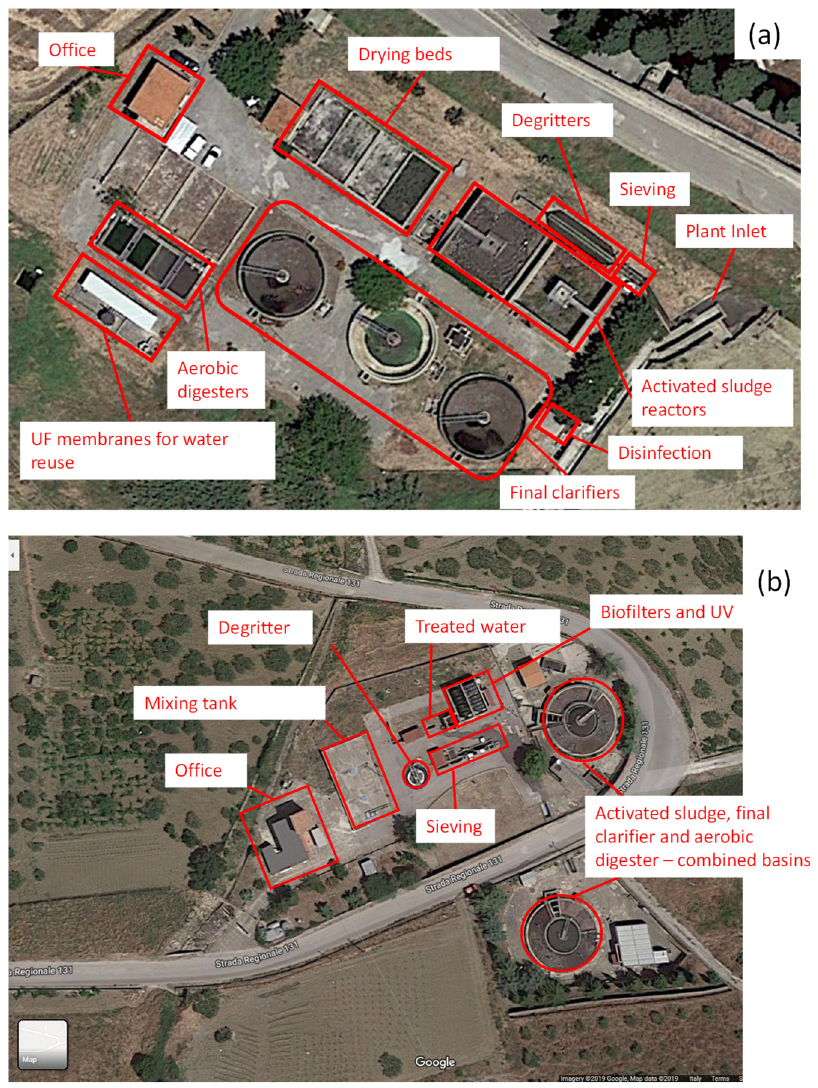
Figure 1. Panoramic view of the Corleone ( a ) and Marineo ( b ) WWTPs (source https://earth.google.com/web/ accessed on 20 July 2020).